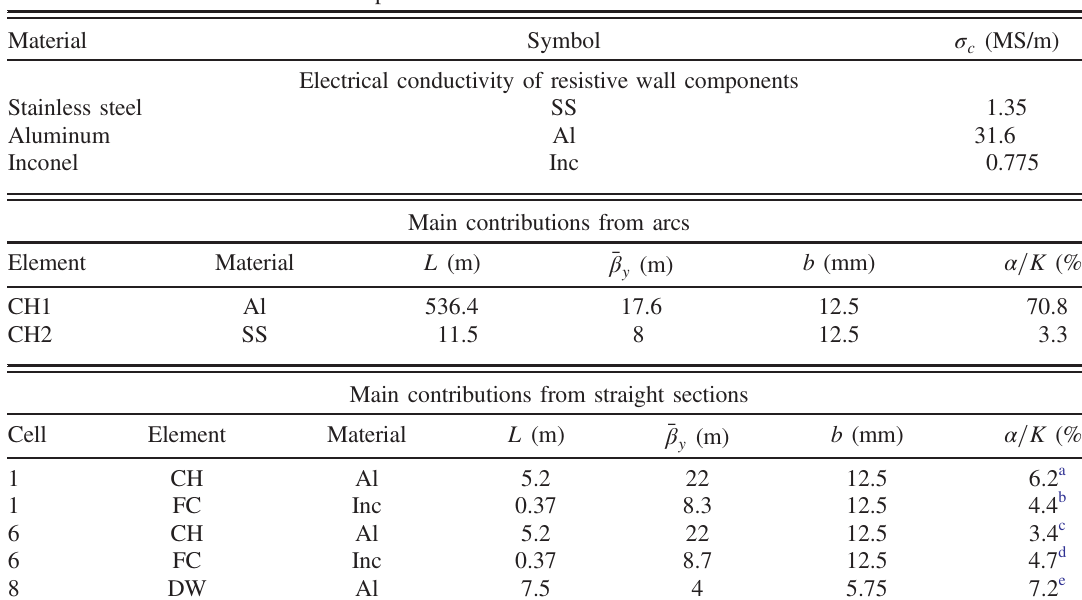
TABLE I. NSLS-II resistive wall